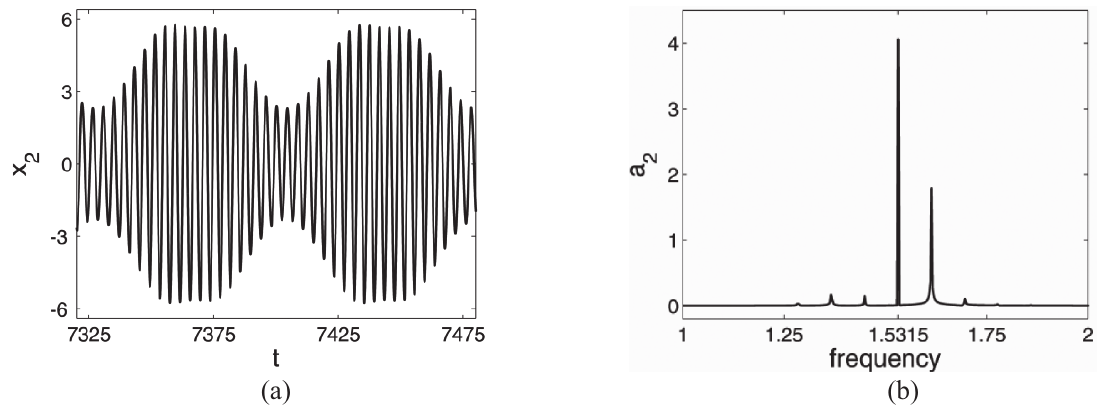
Fig. 8. Time series (a) and FFT (b) for quasi-periodic controller response; x 0 = 0.01, Ω =